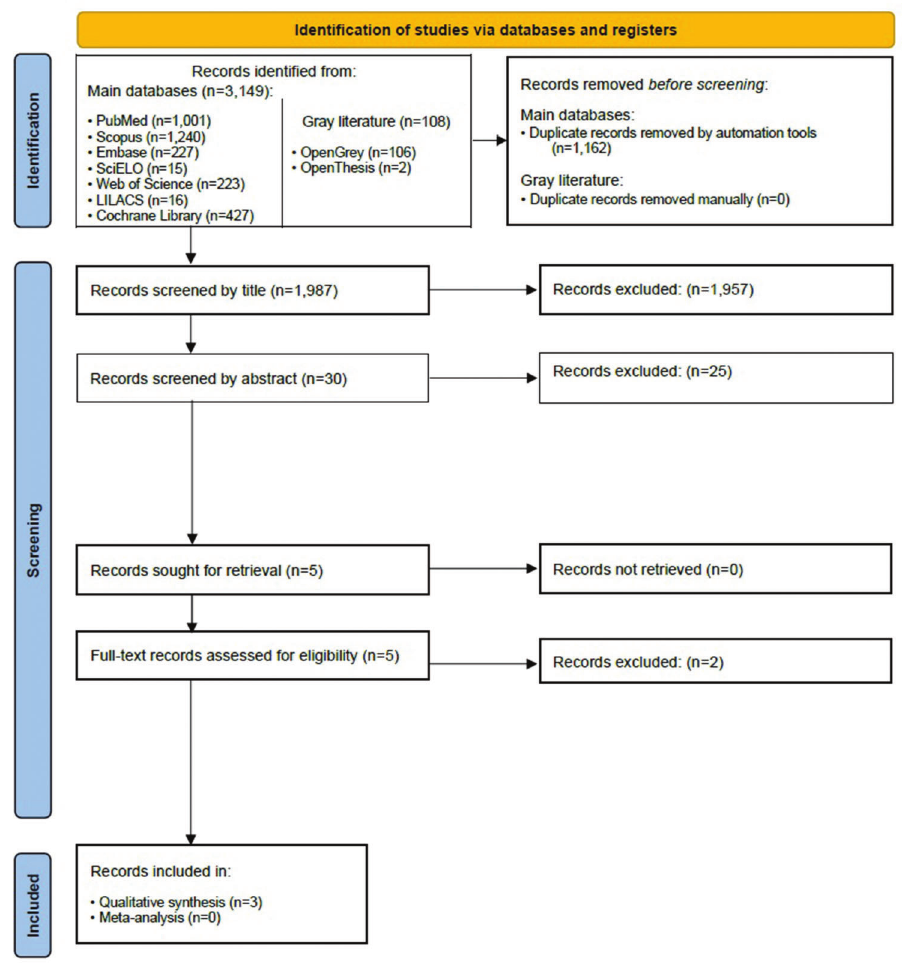
Figure 1 - Preferred Reporting Items for Systematic Review and Meta-Analysis (PRISMA) 2020 flow